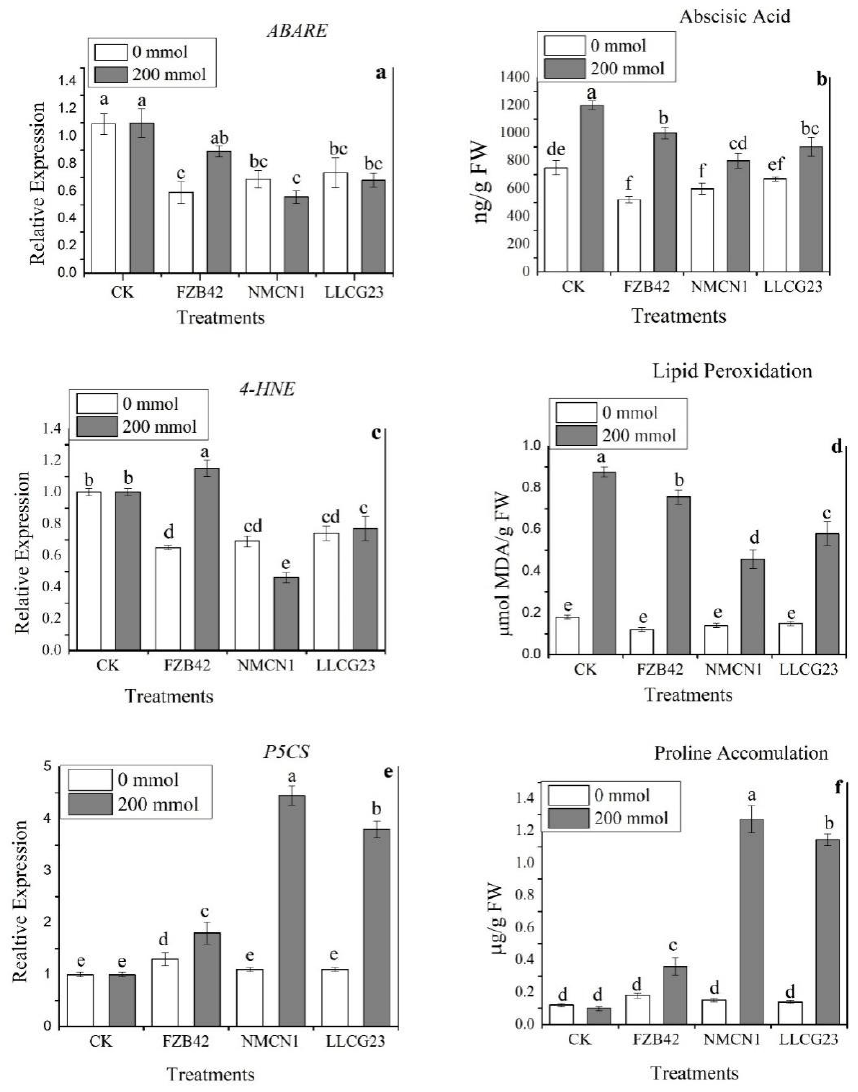
Figure 6. Relative expression and quantification of Abscisic acid, Proline and Lipid peroxidisation. ( a ) Expression profiling of abscisic acid (ABA) encoding gene ABARE , ( b ) ABA quantification through UPLC analysis in wheat plants under salt stress (200 mmol NaCl), ( c ) expression analysis of MDA encoding gene ( 4-HNE ), ( d ) quantification of MDA content through spectrophotometric method in wheat plants grown under saline condition, ( e ) expression analysis of proline encoding gene P5CS, ( f ) spectrophotometric quantification of proline. The error bars on the columns represent the standard deviation of the mean ( n = 3). The small letters were used to show significant difference among the treatments calculated through Tukey’s HSD test at p ≤ 0.05. The experiment was repeated thrice with three replicates for each treatment.